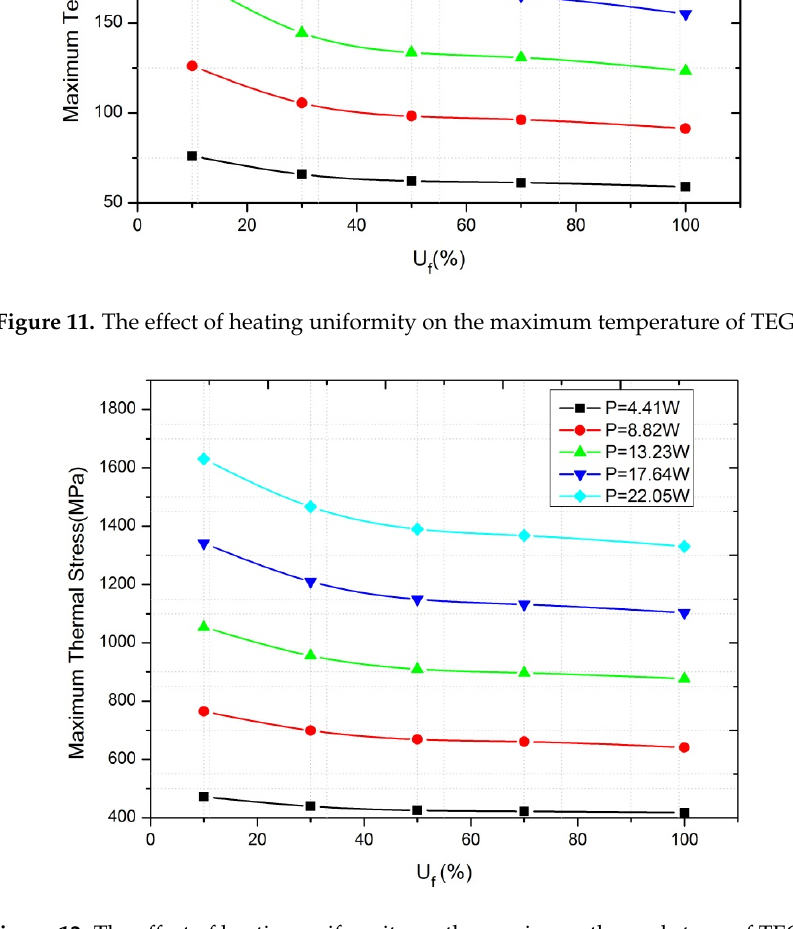
Figure 12. The effect of heating uniformity on the maximum thermal stress of TEG.